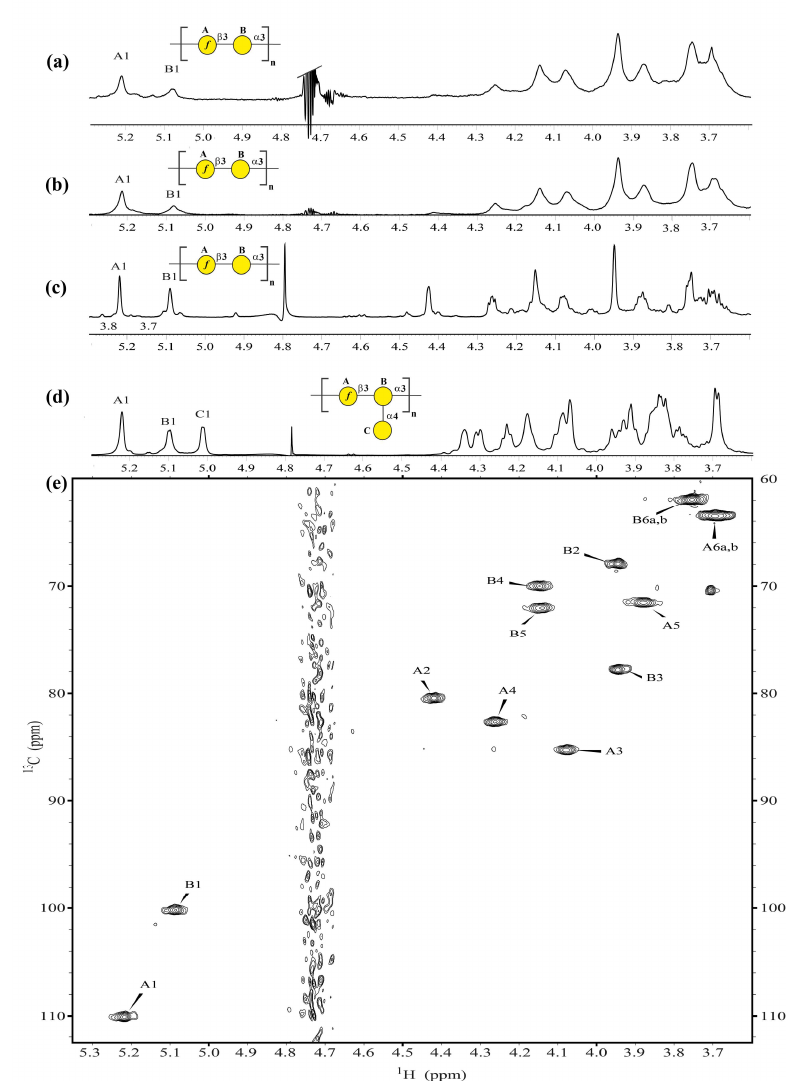
Figure 2. Comparative NMR analysis of K. pneumoniae O2v2 and O2v1 O-antigens. 1 H HR-MAS NMR spectra of the lipopolysaccharides from ( a ) K. pneumoniae BIDMC 7B and ( b ) ABC152; and ( c ) the O-specific polysaccharides of K. pneumoniae Kp26 strain (O2v1) and ( d ) the PCM-27 strain (O2v2); ( e ) 1 H, 13 C HSQC-DEPT NMR spectrum of the BIDMC 7B strain (O2v1). The capital letters refer to protons and/or carbons of O-PS carbohydrate residues, as shown in Table 1. The symbol Nomenclature for Graphical Representation of Glycans is used for O-PS visual representation: Galactose; Galactofuranose to show O-specific polysaccharide repeating units: → 3)- β -D-Gal f -(1 → 3)- α -D-Gal p -(1 → (D-galactan I, O2 variant 1) and → 3)- β -D-Gal f -(1 → 3)-[ α -D-Gal p -(1 → 4)]- α -D-Gal p -(1 → (O2v2)